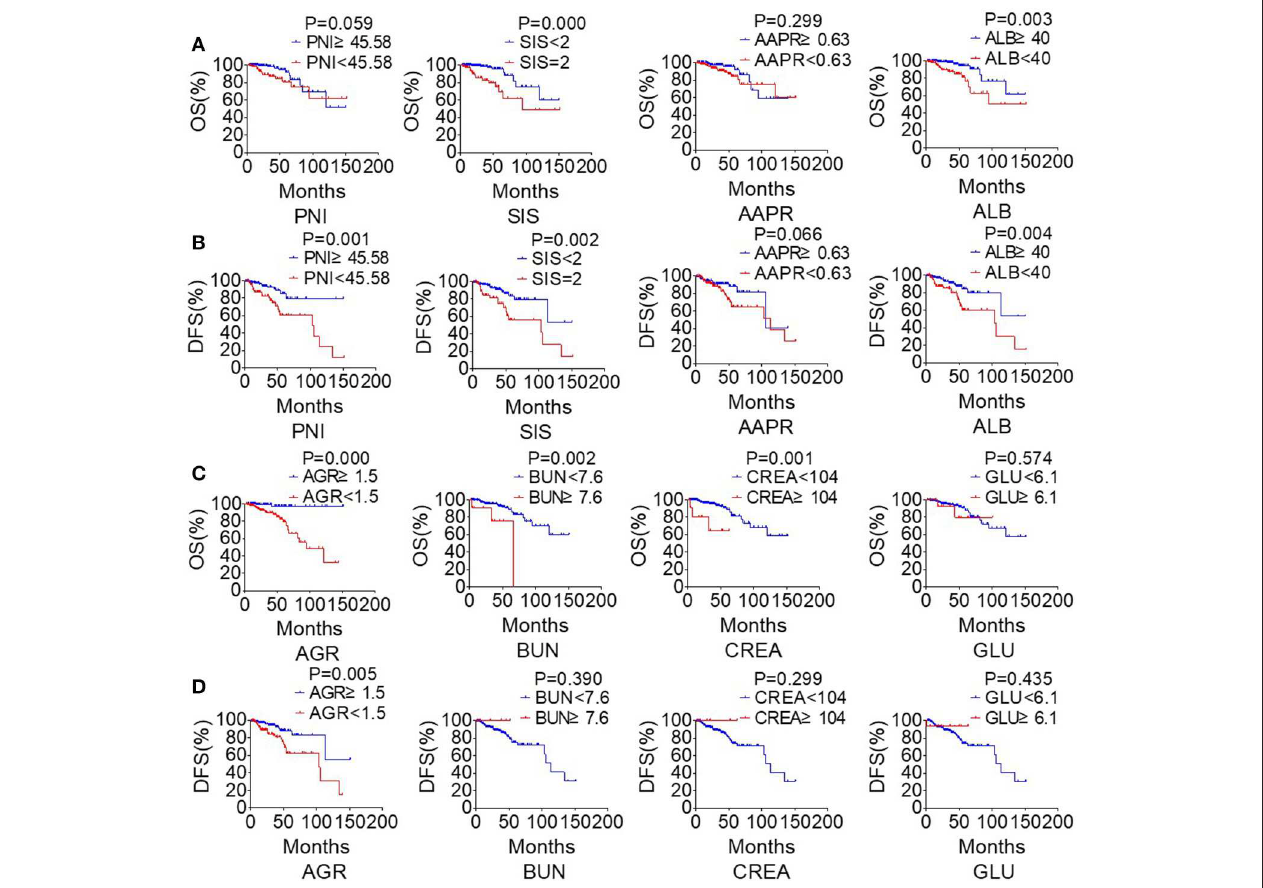
FIGURE 6 | The clinical biochemistry-based indexes predict survival in NPC. Estimated overall survival (OS) (A) and disease-free survival (DFS) (B) curves for PNI, SIS, AAPR, ALB. Estimated overall survival (OS) (C) and disease-free survival (DFS) (D) curves for AGR, BUN, CREA,